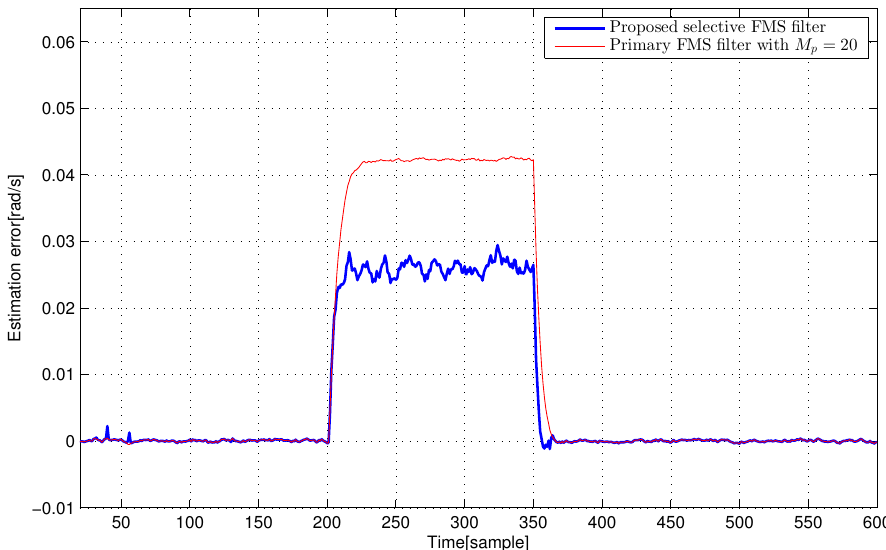
Figure 9. Estimation errors of the proposed selective FMS and primary FMS filters for the electric motor system.